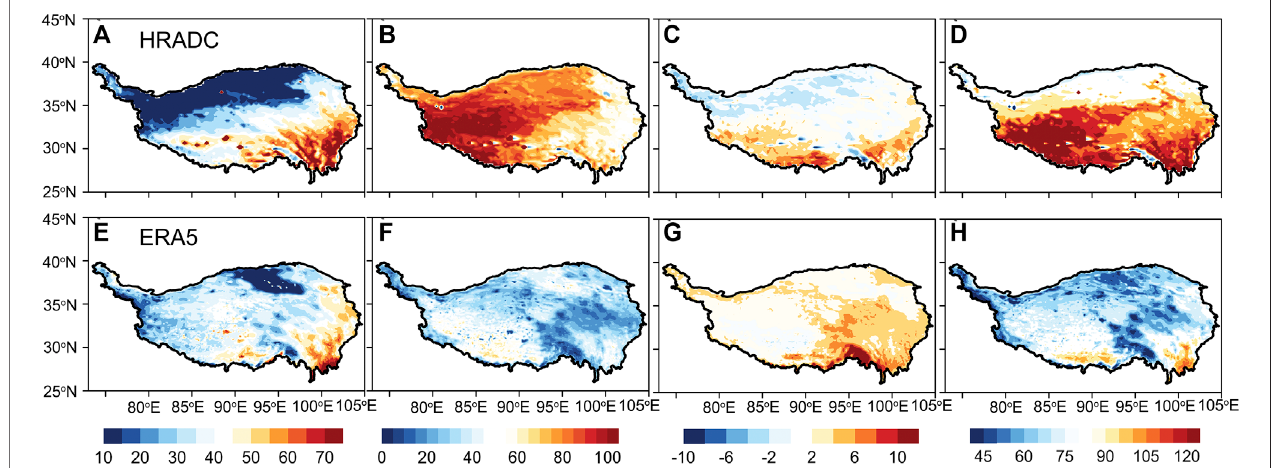
FIGURE 10 | The comparison of spatial distribution of heat fl uxes between High-Resolution Assimilation Dataset of the Water-Energy Cycle in China and ERA5 in the Qinghai-Tibet Plateau (Unit: W · m − 2 ). (A , E) latent heat fl ux, (B , F) sensible heat fl ux, ( C, G) ground heat fl ux, and (D , H) net radiation.